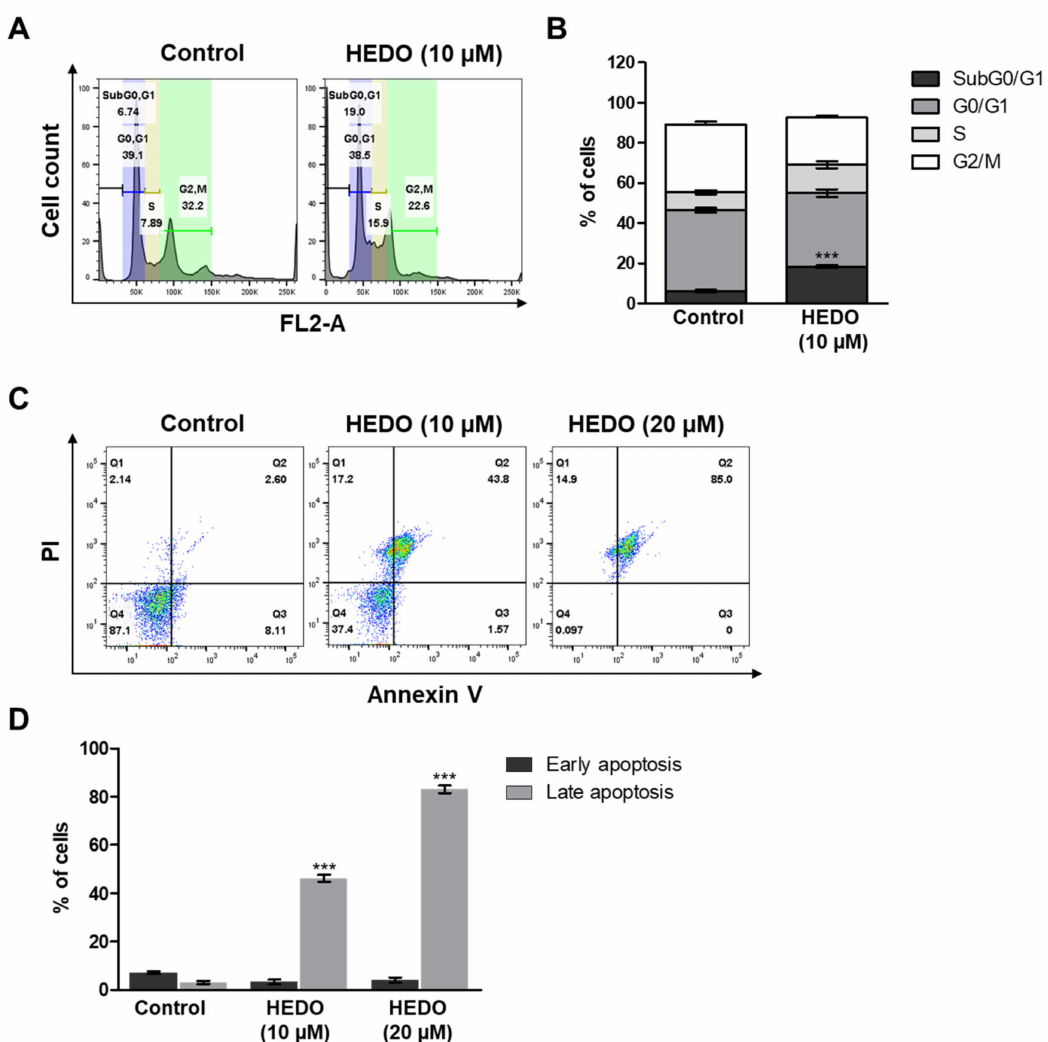
Figure 5. Altered cell cycle progression and apoptosis of OCI-LY3 cells due to HEDO (10 µ M). ( A ) Percentage of cells in the subG0 / G1, G0 / G1, S, and G2 / M phases after treatment with each compound. Cells were analyzed through flow cytometry. ( B ) Cell cycle analysis of cells from the same three experiments. *** p < 0.001 versus control group. ( C ) OCI-LY3 cells were either treated with HEDO or untreatedfor72handapoptosiswassubsequentlyevaluatedthroughflowcytometry. ( D )Quantification of apoptotic cells. Values indicate the means ± SEM. (n = 3, *** p ≤